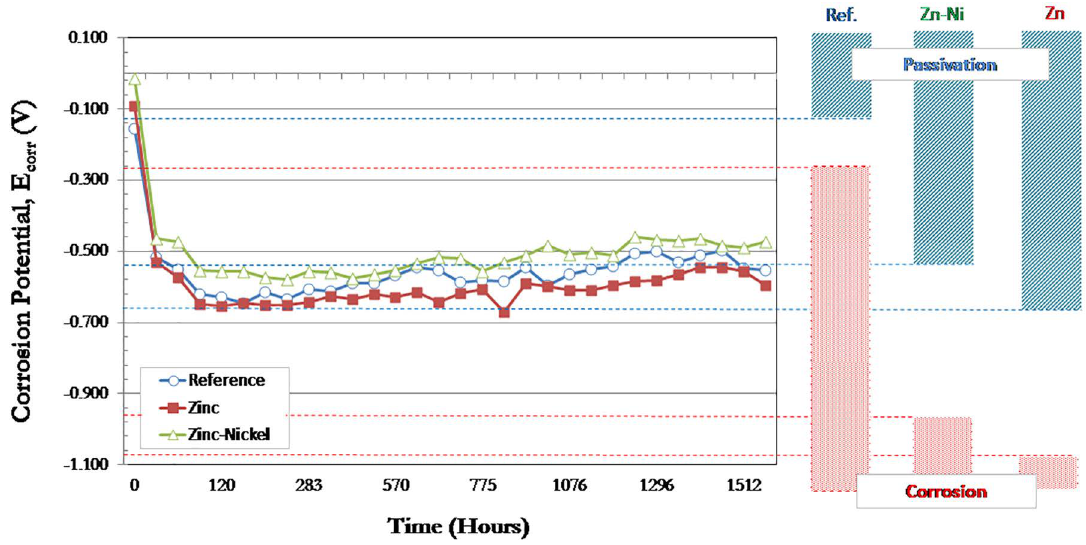
Figure 6. Evolution of the corrosion potential of reference and coated rebars exposed to semi-cycles of partial immersion in 3 wt% NaCl and drying in a ventilated oven.